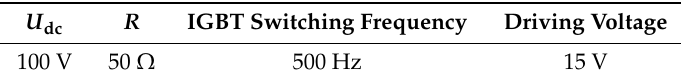
Table 1. Main circuit parameter.